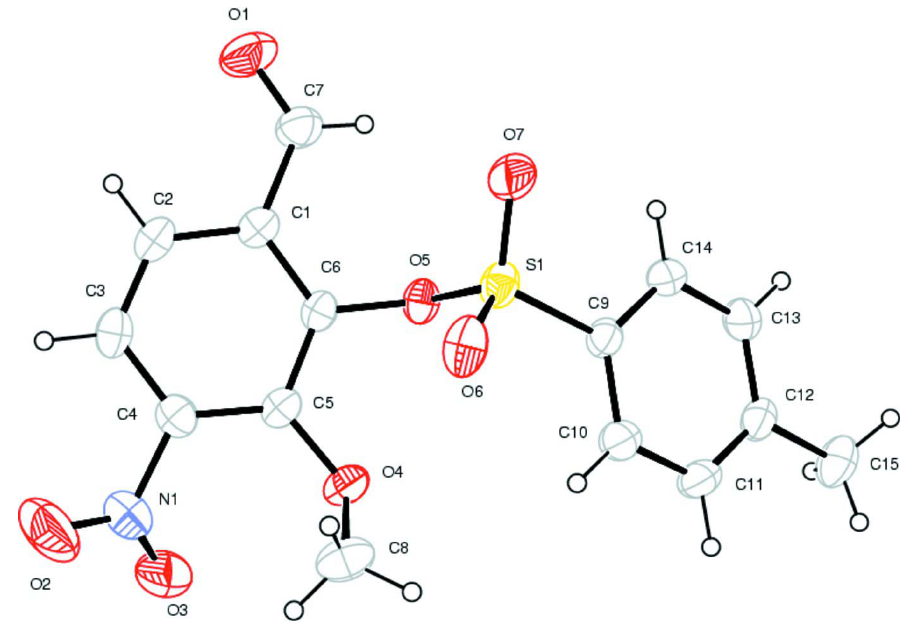
Figure 1 ORTEP of the molecule with atoms represented as 30% probability ellipsoids. 6-Formyl-2-methoxy-3-nitrophenyl 4-toluenesulfonate Crystal